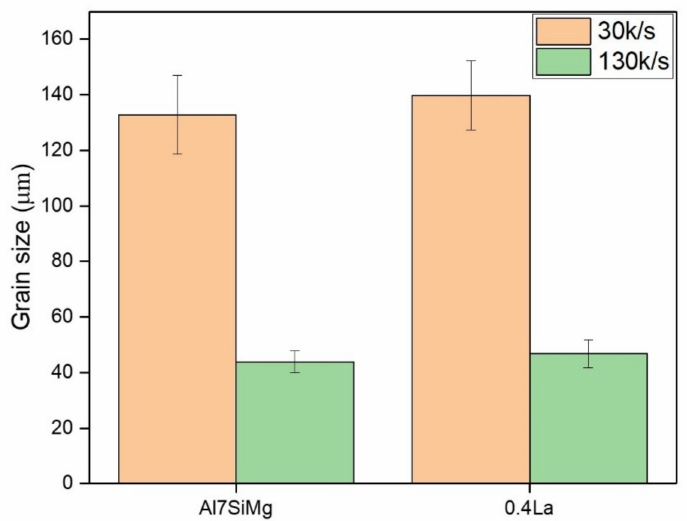
Figure 10. Measurement of α -Al grain size in Al7SiMg alloys without and with 0.4La at the cooling rates of 30 and 130 K /